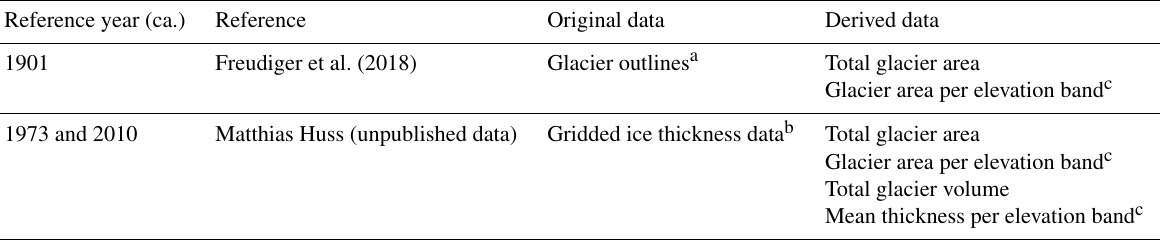
Table A1. Glacier datasets with reference and derived data for the reference years 1900, 1973, and 2010 used for the reconstruction of initial glacier geometry for the Alpbach